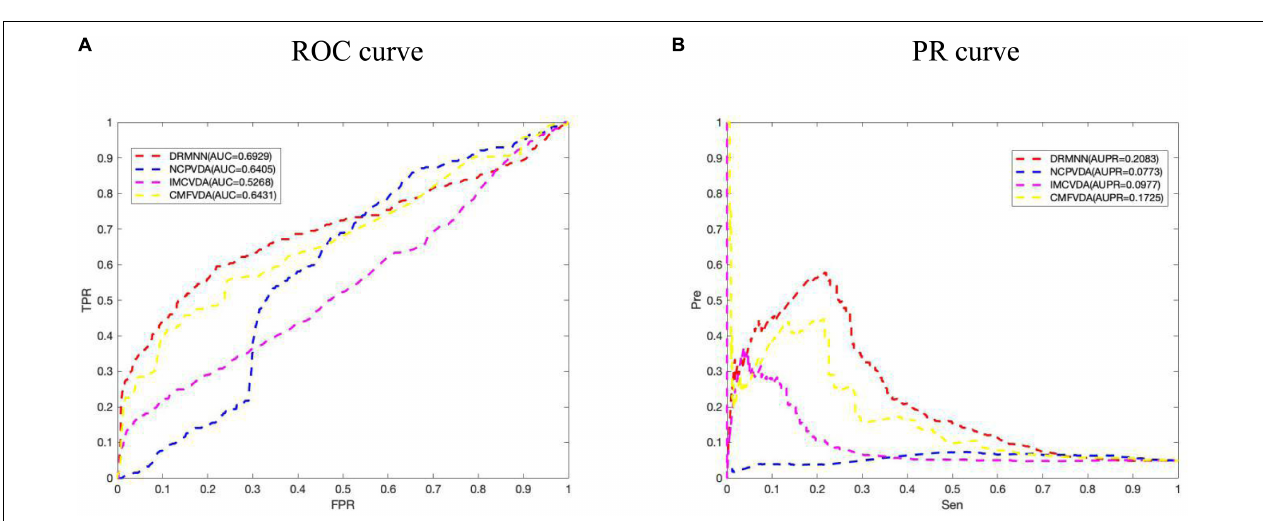
Frontiers in Physiology |